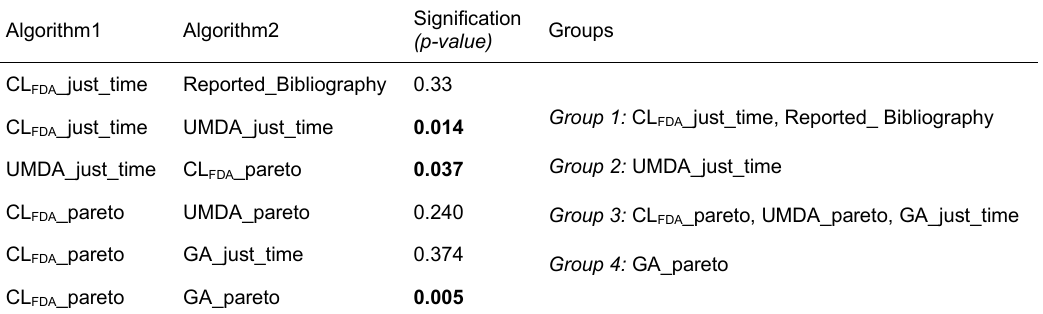
Table 2. Comparison results using Wilcoxon test, variable Mean_Makespan for j30_17